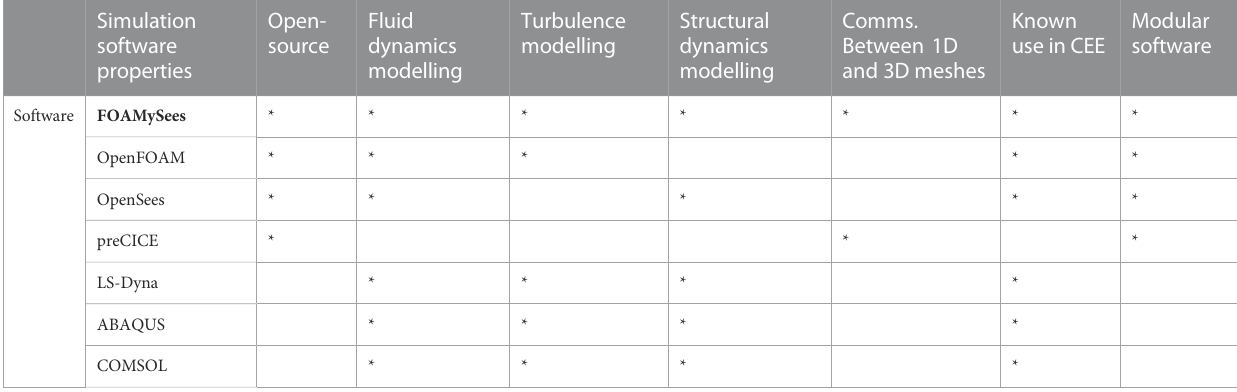
TABLE 1 Simulation capabilities for various parallelized software programs utilized for non-linear computational continuum mechanics.